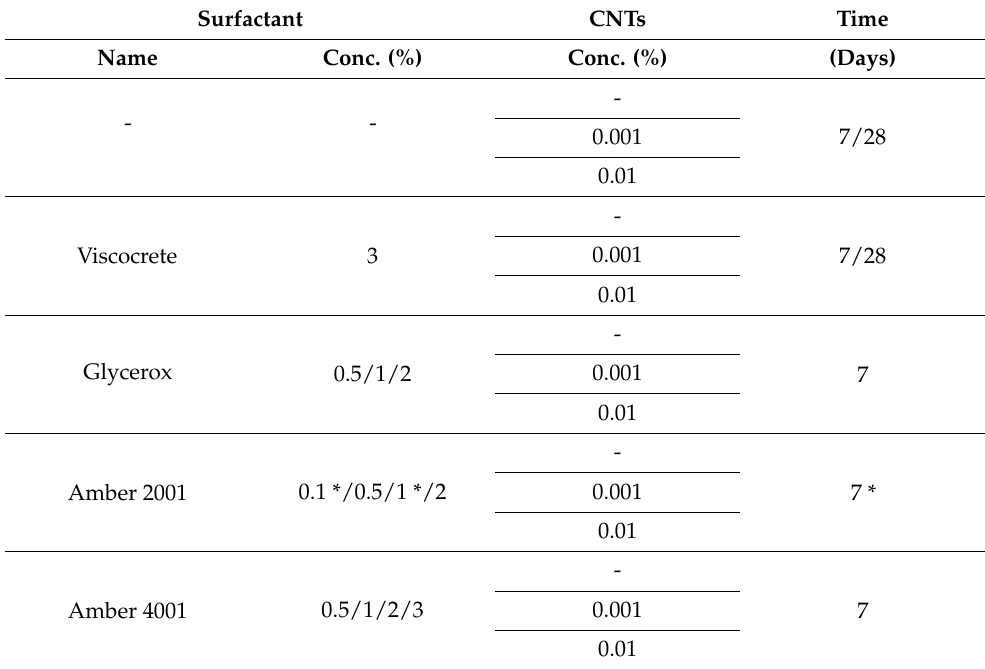
Table 1. Experimental testing